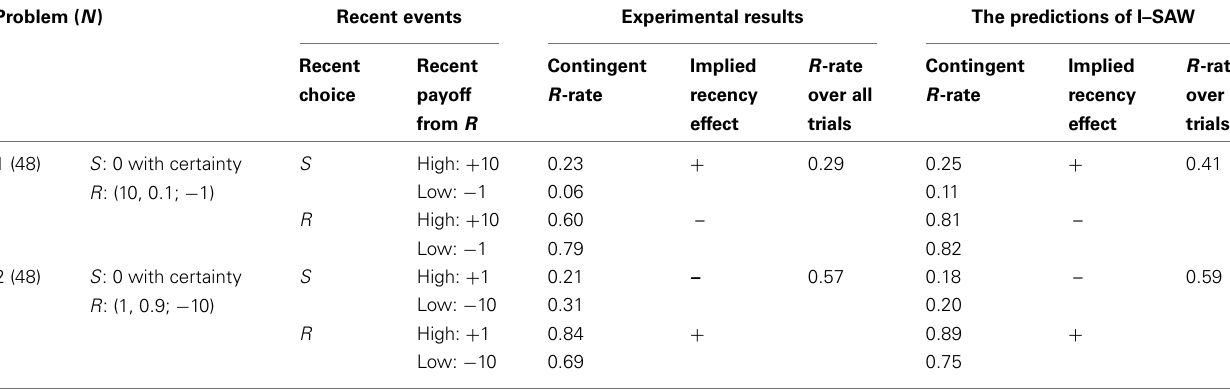
Table 1 |The two new problems studied in Experiment 1, and the main